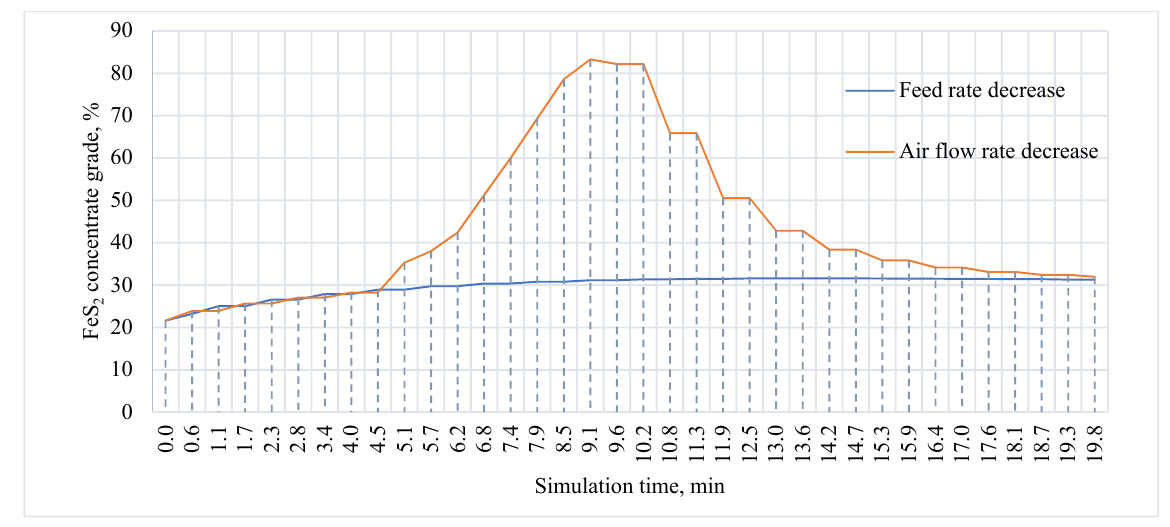
Figure 13. FeS 2 concentrate recovery values in the simulation.